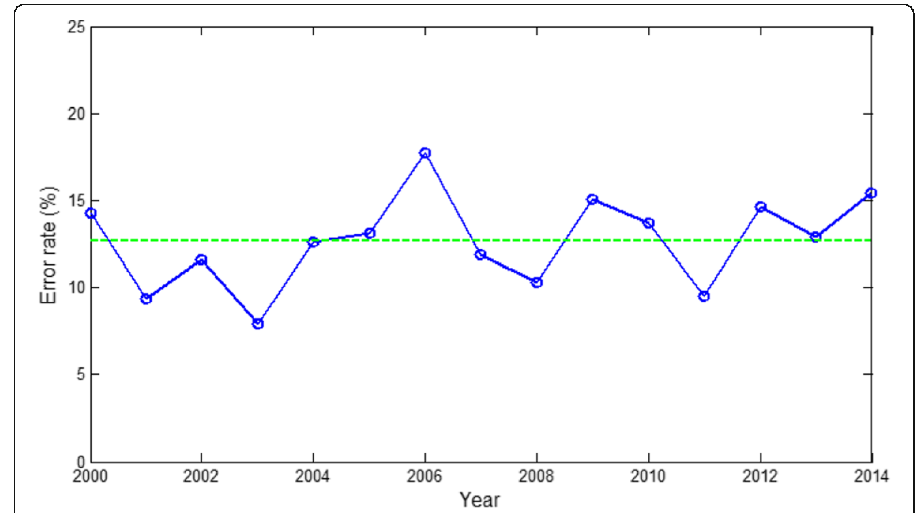
Fig. 8 Network prediction error